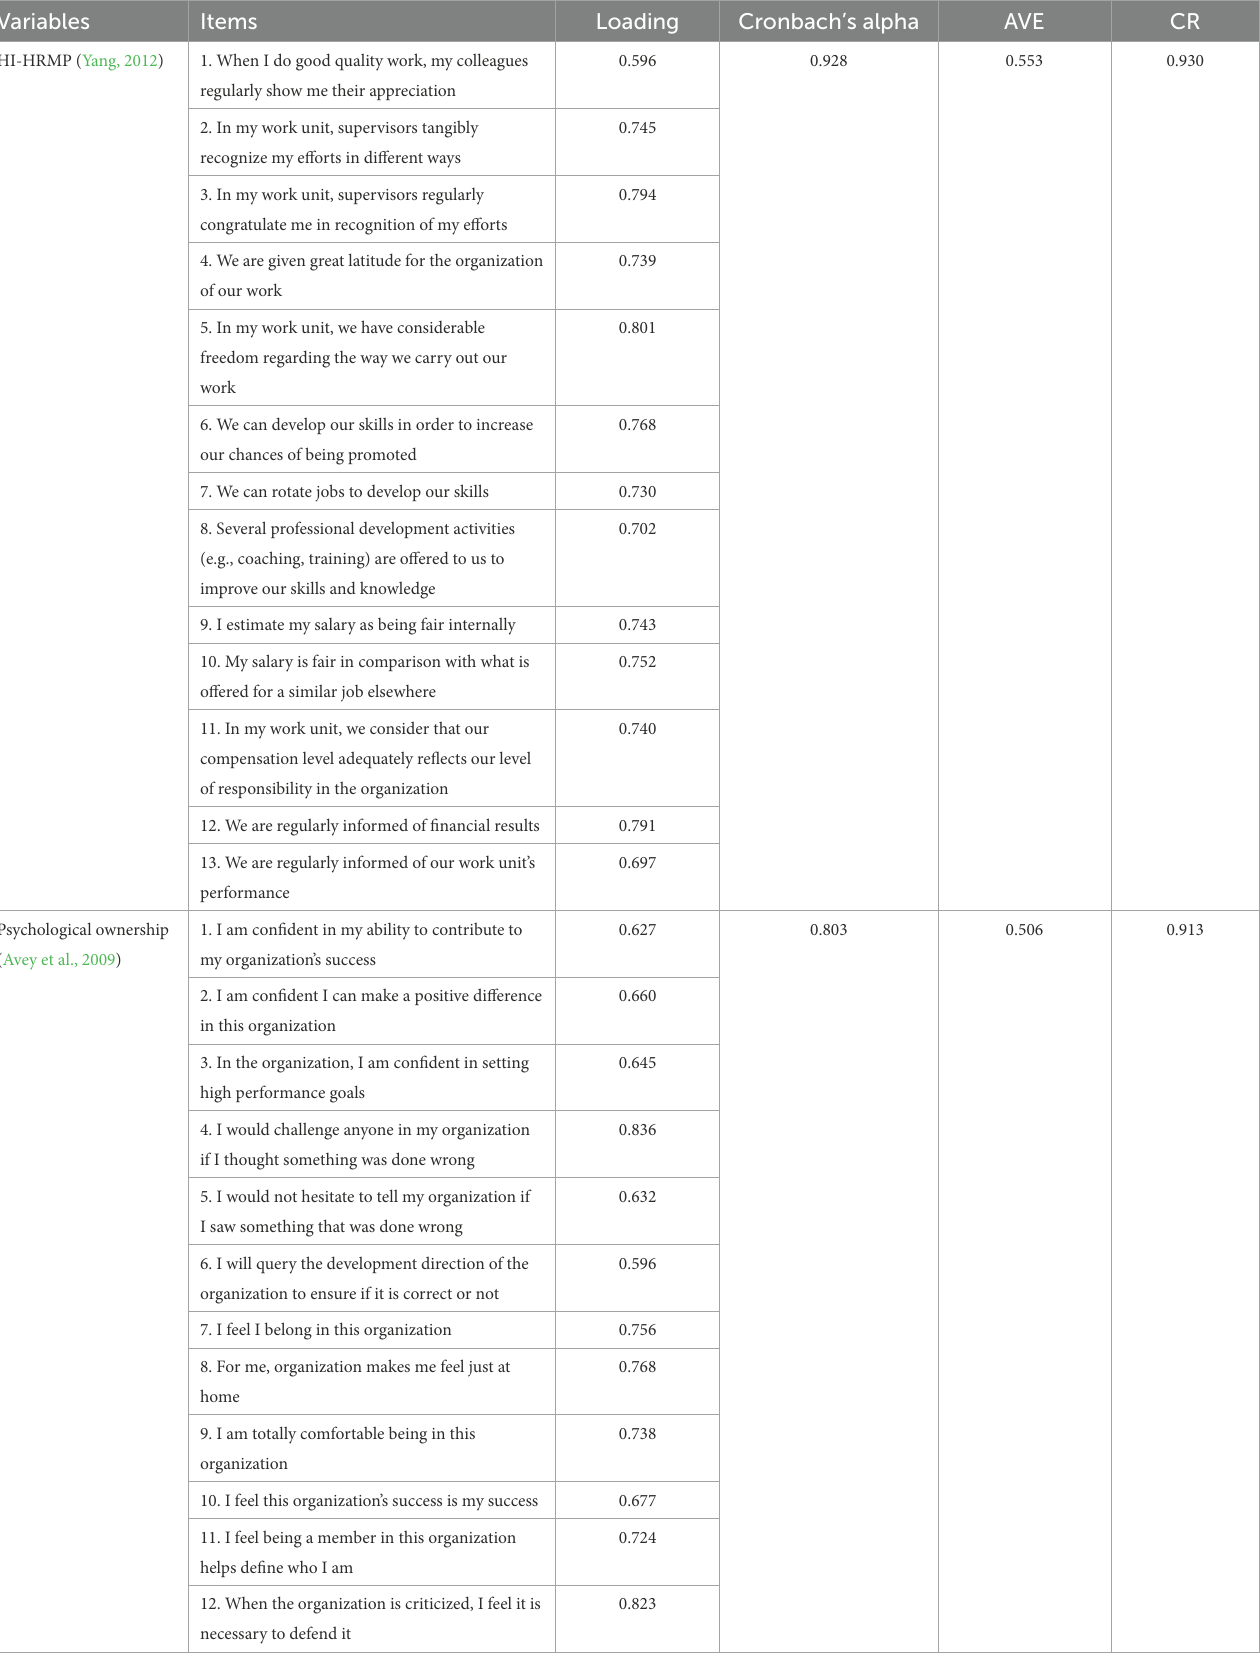
TABLE 1 Results of the reliability analysis ( N = 251).